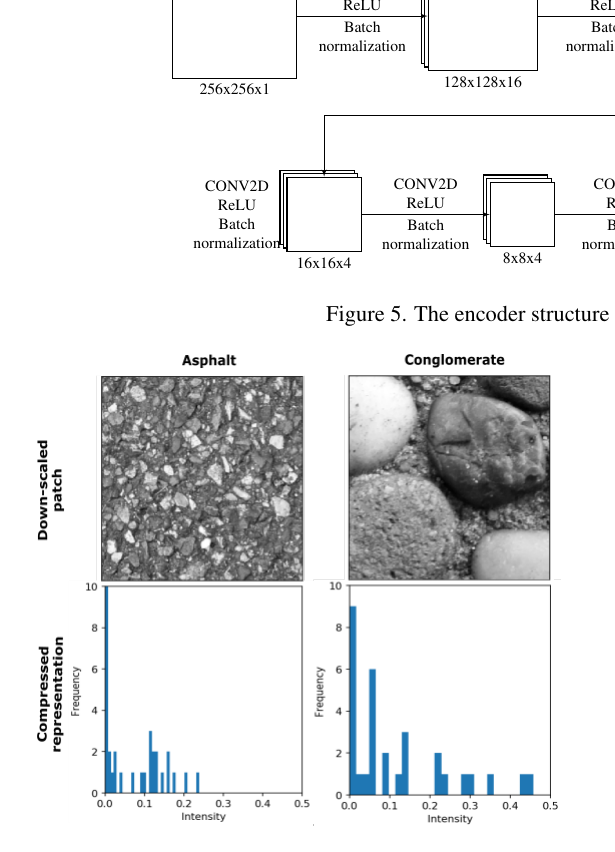
Figure 6. Examples for the two material classes Conglomerate and Asphalt . Upper row: the down-scaled image patches. Lower row: The corresponding compressed textural representation visu- alizing the intensity